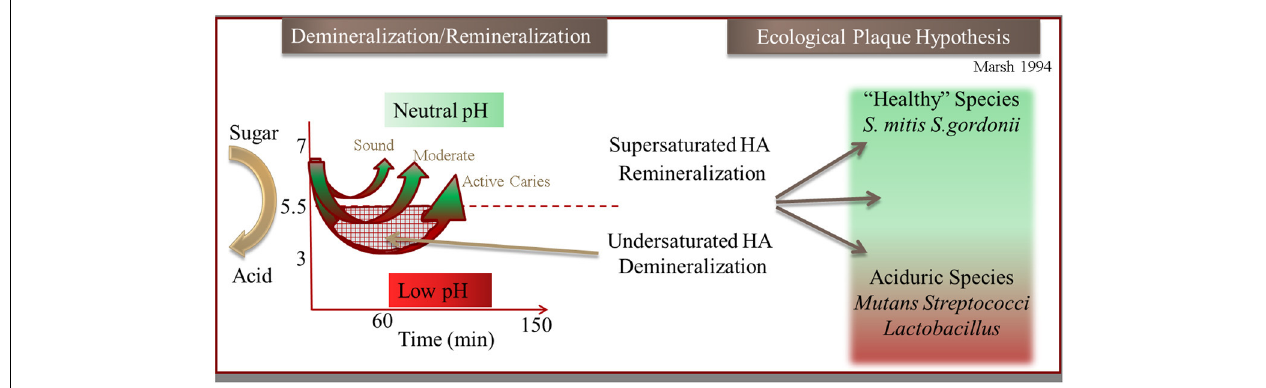
FIGURE 2 | Illustration of the hydroxyapaptite (HA) demineralization and remineralization process that occurs through the pH cycling (“Stephan Curve”) in relation to the Ecological Plaque Hypothesis (adapted from Marsh,